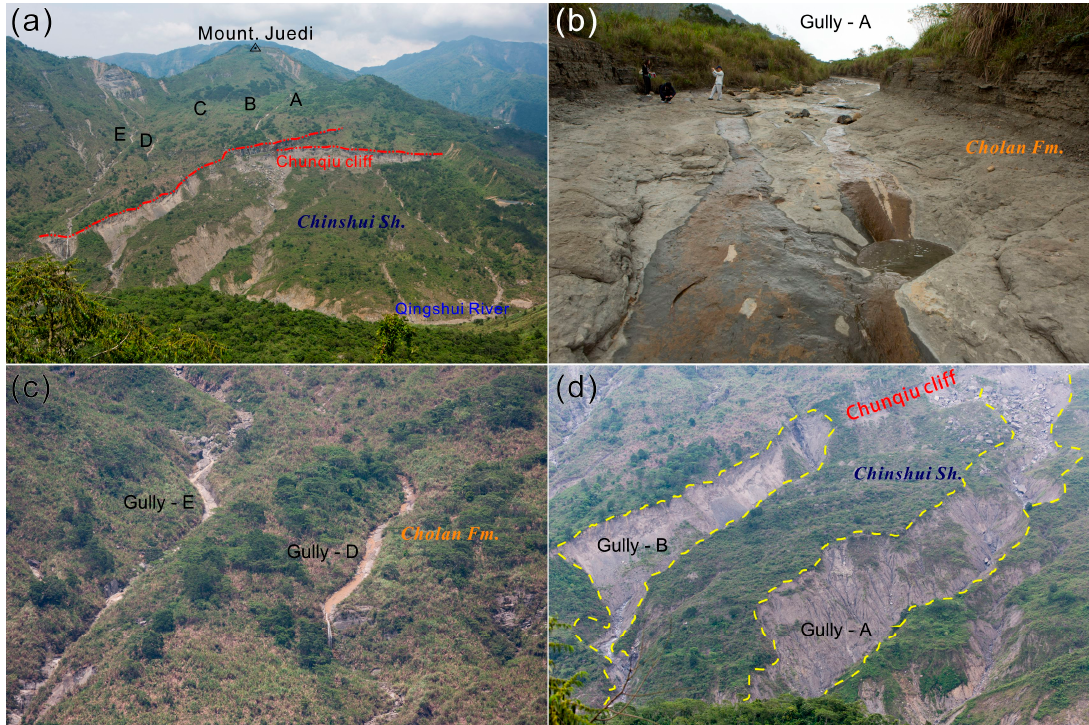
Figure 9. Field images showing the current situation of the Tsaoling landslide slope gullies taken on 21 April 2016: ( a ) An overview of the entire Tsaoling landslide area. On the slope, only the gullies and parts of the shallow landslides show bare ground, while the remaining area is covered by vegetation; ( b ) The exposure area of Gully A in the Cholan Formation. The gully sidewall is an interlayer of sandy shale, and the bottom of gully bed is a thick layer of sandstone; ( c ) Gullies D and E eroded from the sandstone surface of the Cholan Formation; ( d ) The wide and deep Gullies A and B within the range of the Chinshui Shale, which are quite different in geomorphology compared to the gullies formed within the Cholan Formation shown in ( b , c ).